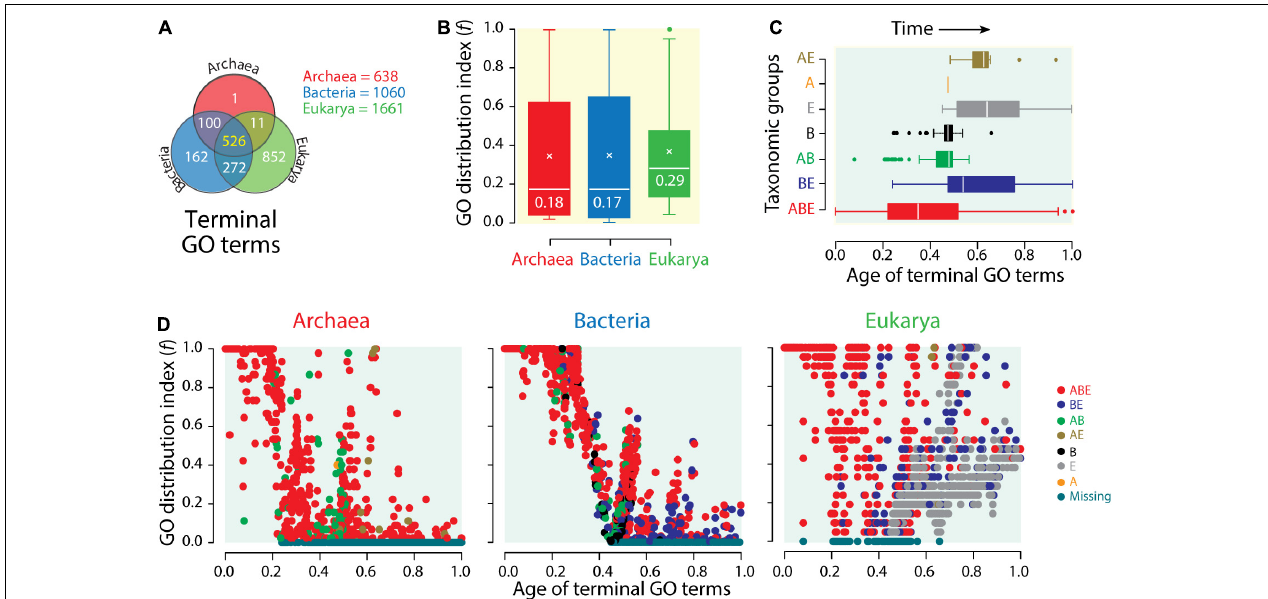
FIGURE 5 | The compressed functional vocabularies of microbial domains. (A) Venn diagram showing the distribution of terminal Gene Ontology (GO) terms of molecular functions (GO TMF ) of the functionomes of superkingdoms among the seven Venn taxonomic groups (ABE, AB, AE, BE, A, B, and E). (B) The distribution of GO TMF terms among functionomes ( f -index) of each superkingdom is displayed with boxplot representations. (C) Boxplots displaying the distribution of GO TMF terms corresponding to the seven Venn taxonomic groups along an evolutionary timeline of molecular functions, with time expressed as relative ages of GO TMF terms, 0 representing the first function and 1 the present. (D) Scatterplots displaying the distribution of GO TMF terms in functionomes of Archaea, Bacteria, and Eukarya as GO terms of molecular functions unfold in the evolutionary